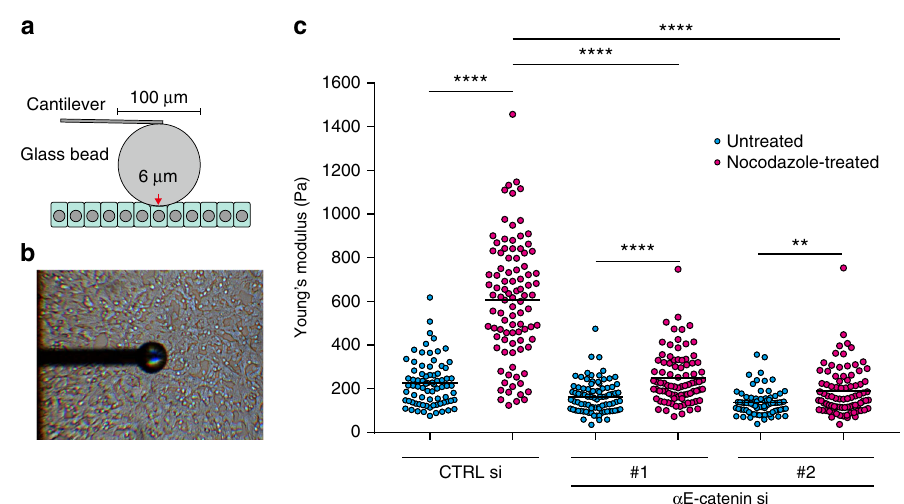
Fig. 8 Measurement of the apical surface stiffness by atomic force microscopy. a Diagrammatic outline of the method. b An example of the experiment. c The stiffness of cells, treated or not treated with nocodazole, at the apical region. n = 77 for CTRL si/untreated, 95 for CTRL si/treated, 86 for α E-catenin si #1/untreated, 86 for α E-catenin si #1/treated, 79 for α E-catenin si #2/untreated, and 84 for α E-catenin si #2/treated. The data were pooled from two independent experiments. ** P = 0.0011, **** P < 0.0001 by two-tailed Mann – Whitney U -test. Black lines show